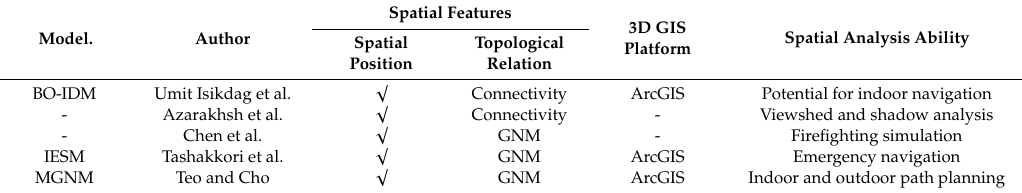
Table 1. Comparative analysis of indoor geographic information system (GIS) models.